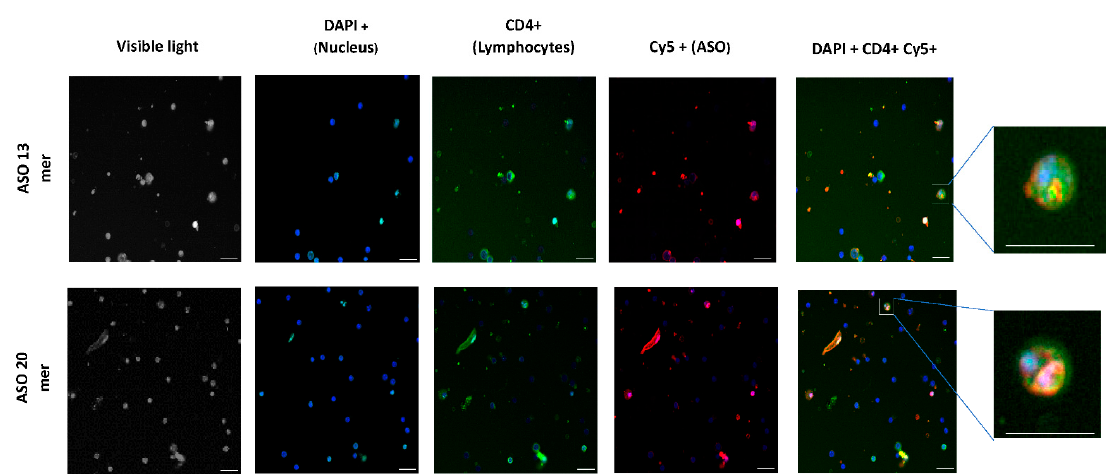
Figure 2. Location of fluorescent ONs in splenic lymphocytes. Splenocytes were treated with Cy5-labeled ONs and incubated for 1 h at 4 µ M. Then, the cells were marked with anti-mouse CD4 FITC, fixed with 4% formaldehyde in phosphate buffered saline (PBS) solution and analyzed using an InCell analyzer 2200 system to observe the uptake of ONs in CD4+ lymphocytes. Scale bar represents 10 µm.